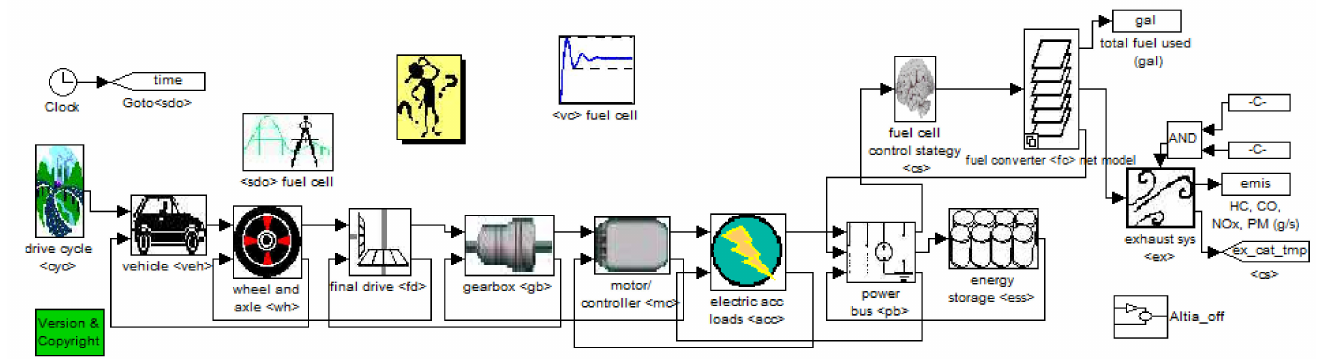
Figure 13. Simulation model on the hydrogen fuel cell vehicle